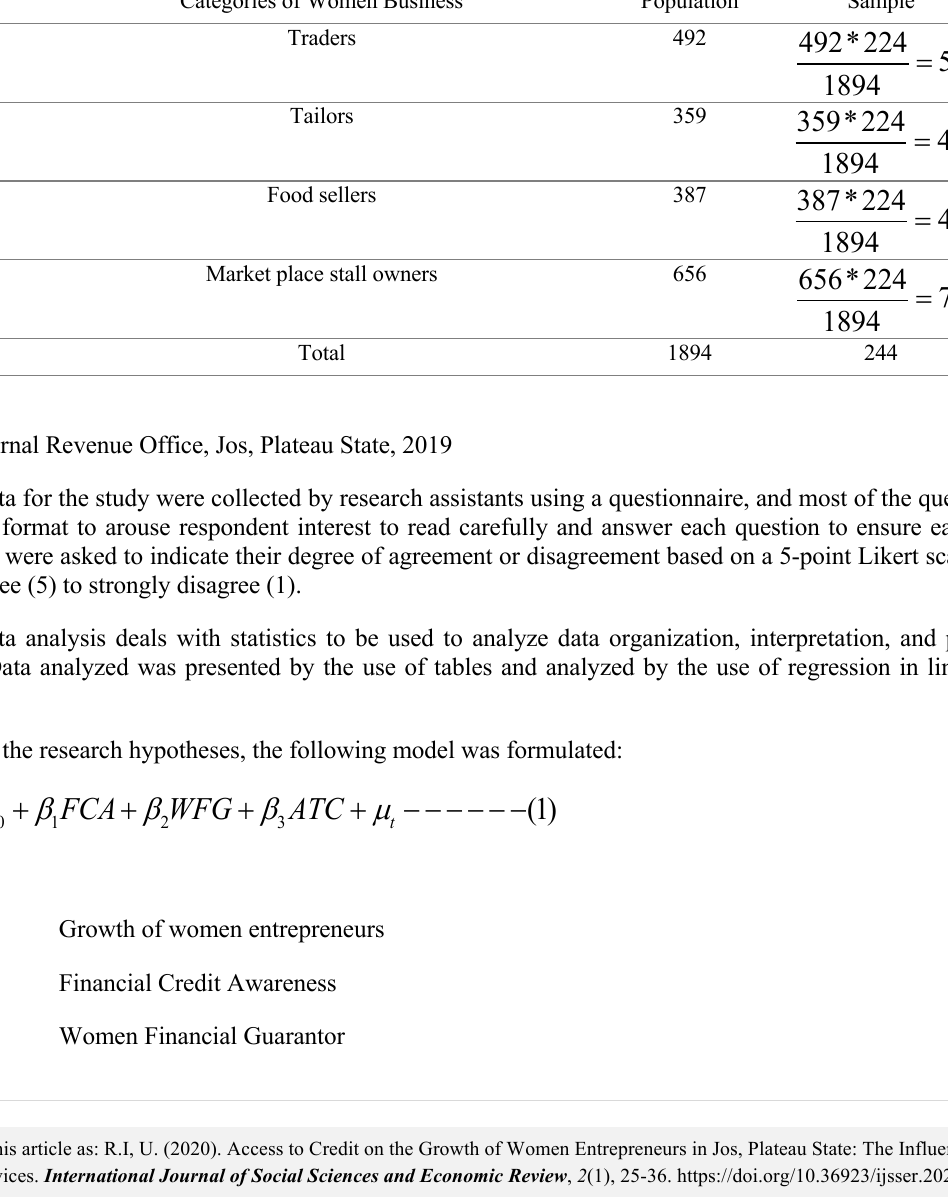
Table 2: Selected Sample of Women Business in Jos, Plateau State